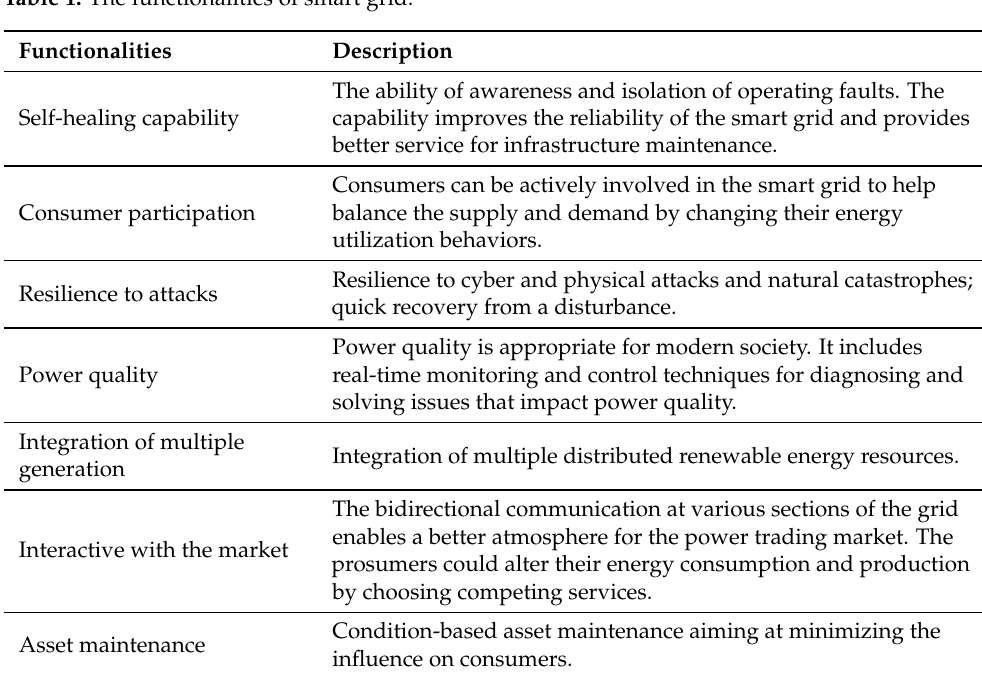
Table 1. The functionalities of smart grid.